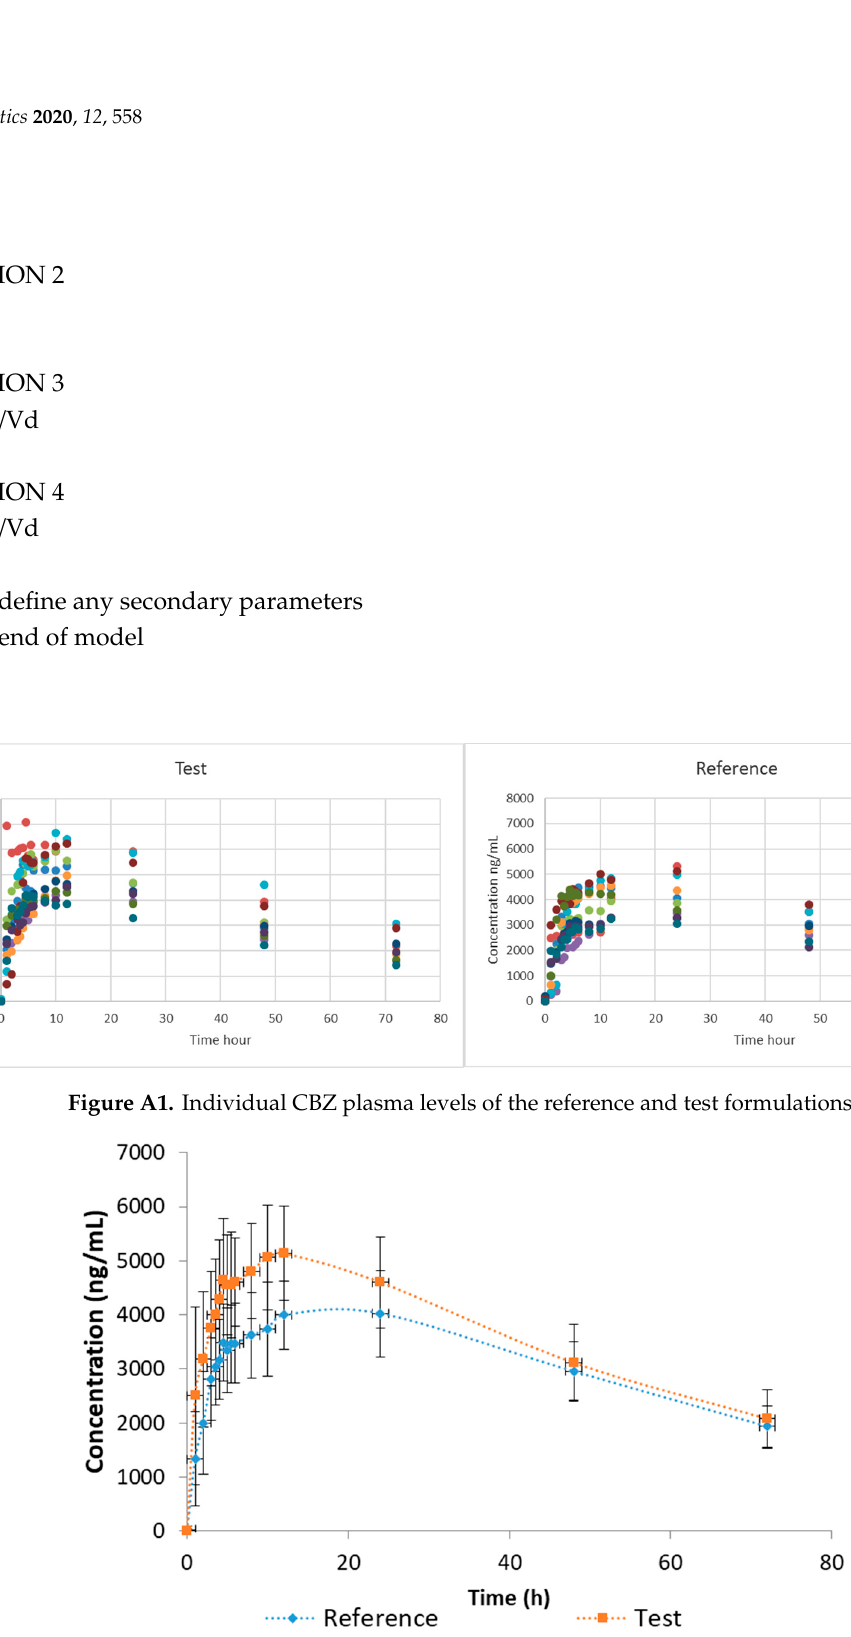
Figure A2 . Average plasma levels of Reference (solid circles) and Test (solid squares) formulations and their standard deviation.